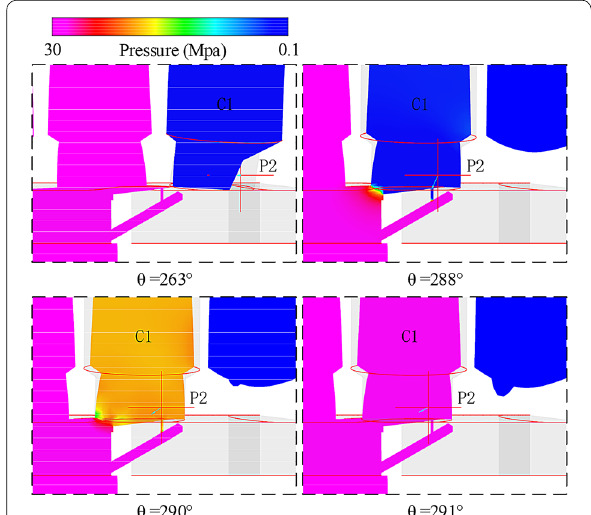
Figure 11 Evolution of cross section II pressure cloud map